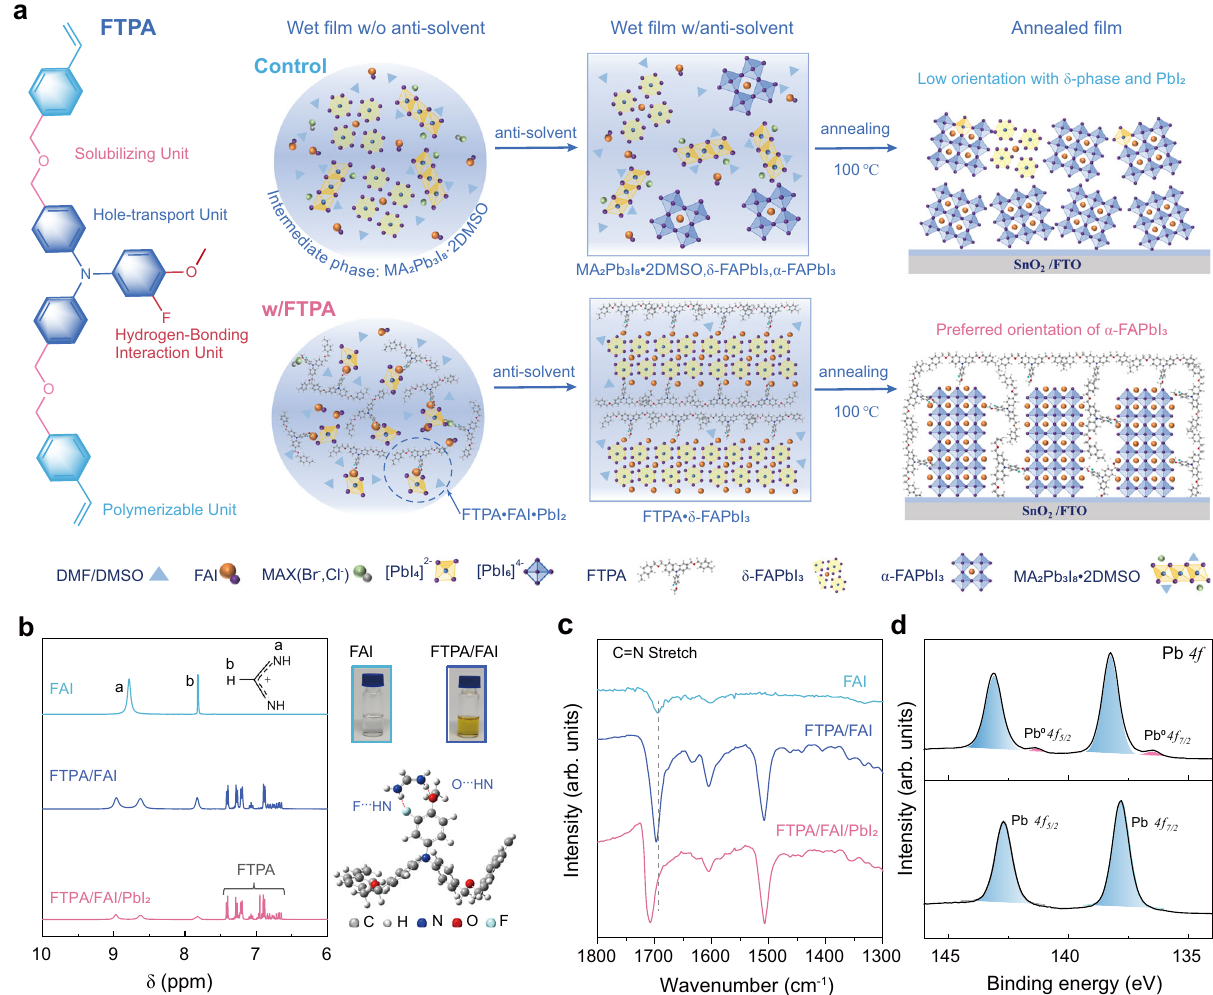
Fig. 1 | Molecular design and interaction between FTPA and perovskite. a MolecularstructuredesignofFTPA,andschematicdiagramofthepossiblephase evolutionofthenucleationandcrystallizationofFA-basedmixedanionperovskites (FA 0.95 MA 0.05 Pb(I 0.95 Br 0.05 ) 3 ) during the fi lm-forming process with (w) or without (w/o) FTPA. In the control perovskite fi lm, the complicated intermediate phases, MA 2 Pb 3 I 8 ·2DMSO and δ -FAPbI 3 , caused two competition pathways of crystal- nucleation as shown in Eqs. (1) and (2), and fi nally resulted in a low crystal orien- tation with δ -phase and PbI 2 . In contrast, perovskite fi lm with FTPA restrained the